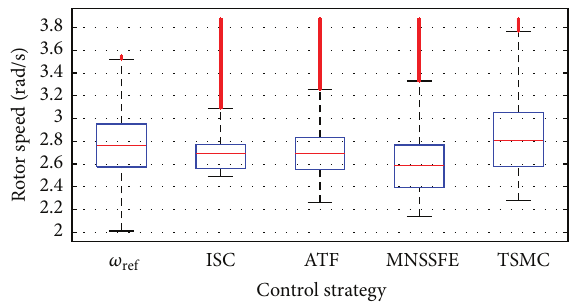
Figure 11: Box plot for rotor speed using FAST simulator.